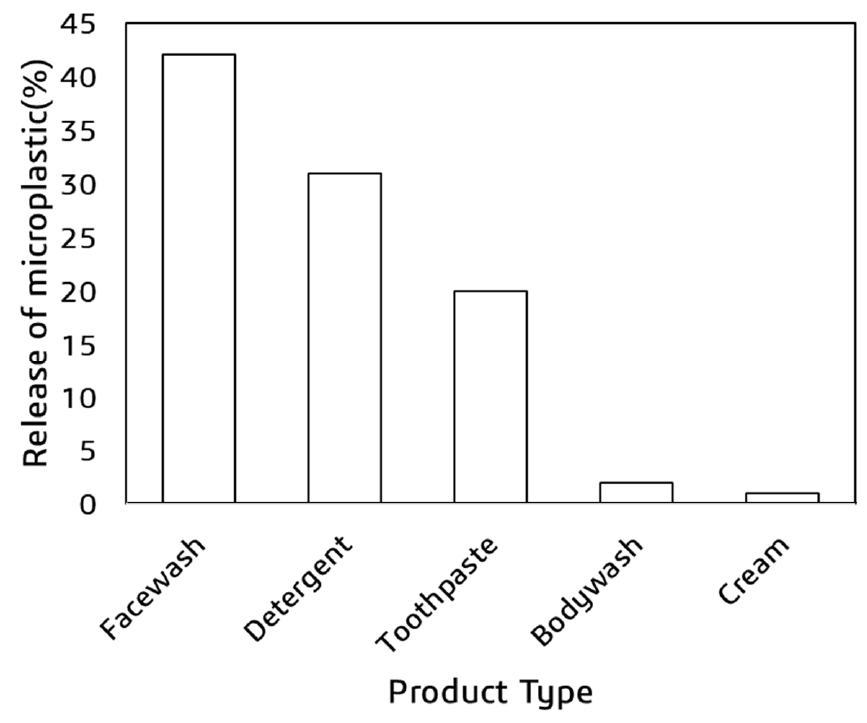
Figure 1. Contribution of various products in releasing microplastic.